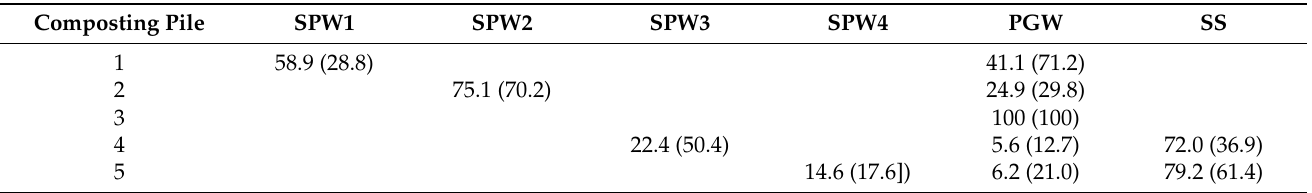
Table 2. Proportions on a fresh weight basis (dry weight basis between brackets) of the raw materials used in the composting